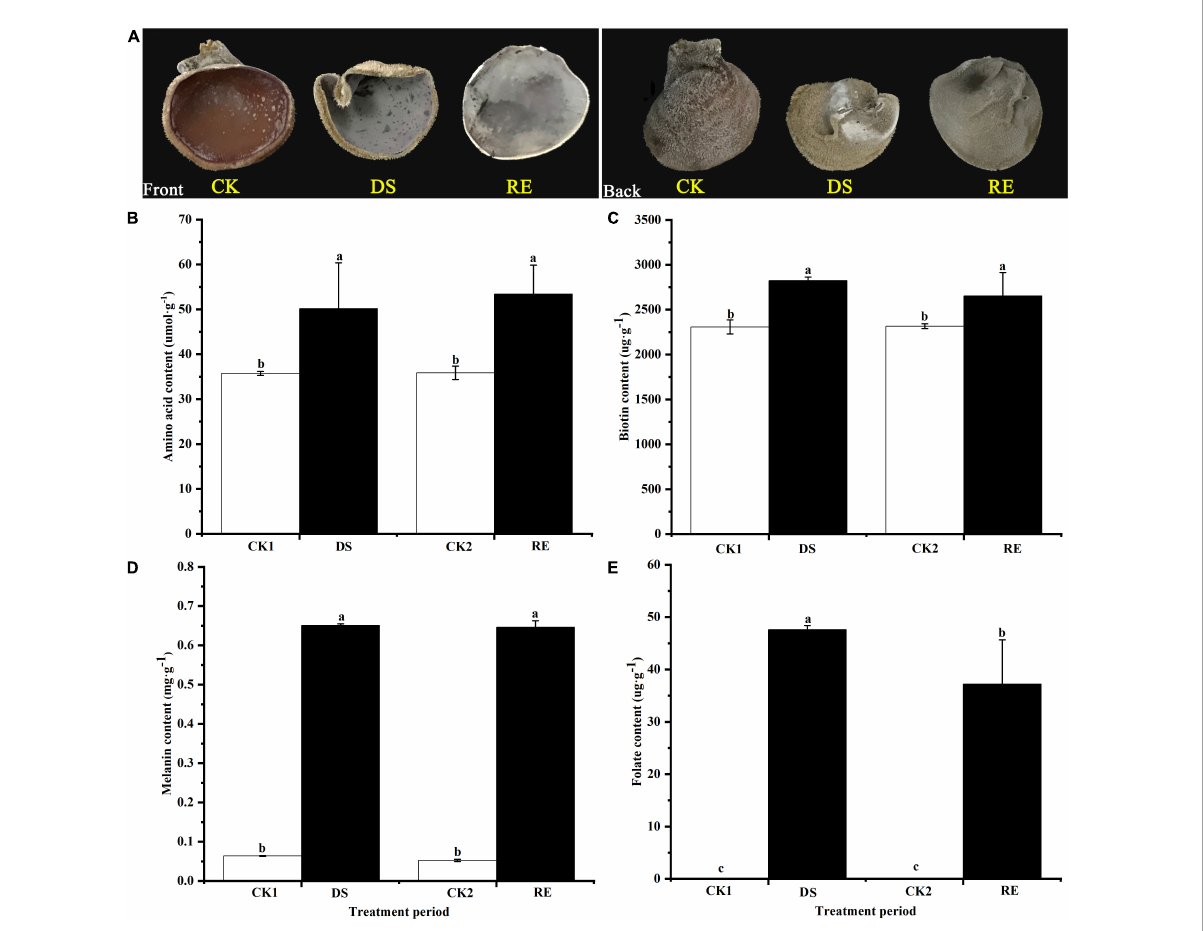
FIGURE1 Phenotype and physiological responses to dessication-stress and rehydration in Auricularia fibrillifera . (A) Phenotypes of fruiting bodies. The front is on the left and the back is on the right. (B) Amino acid, (C) biotin, (D) melanin, and (E) folate content. CK1, CK2, DS, and RE represent the parallel control of desiccation-stress, parallel control of rehydration, desiccation-stress, and rehydration process, respectively. Bars indicate mean ± SD ( n = 3). Values with different letters are significantly different at p < 0.05.